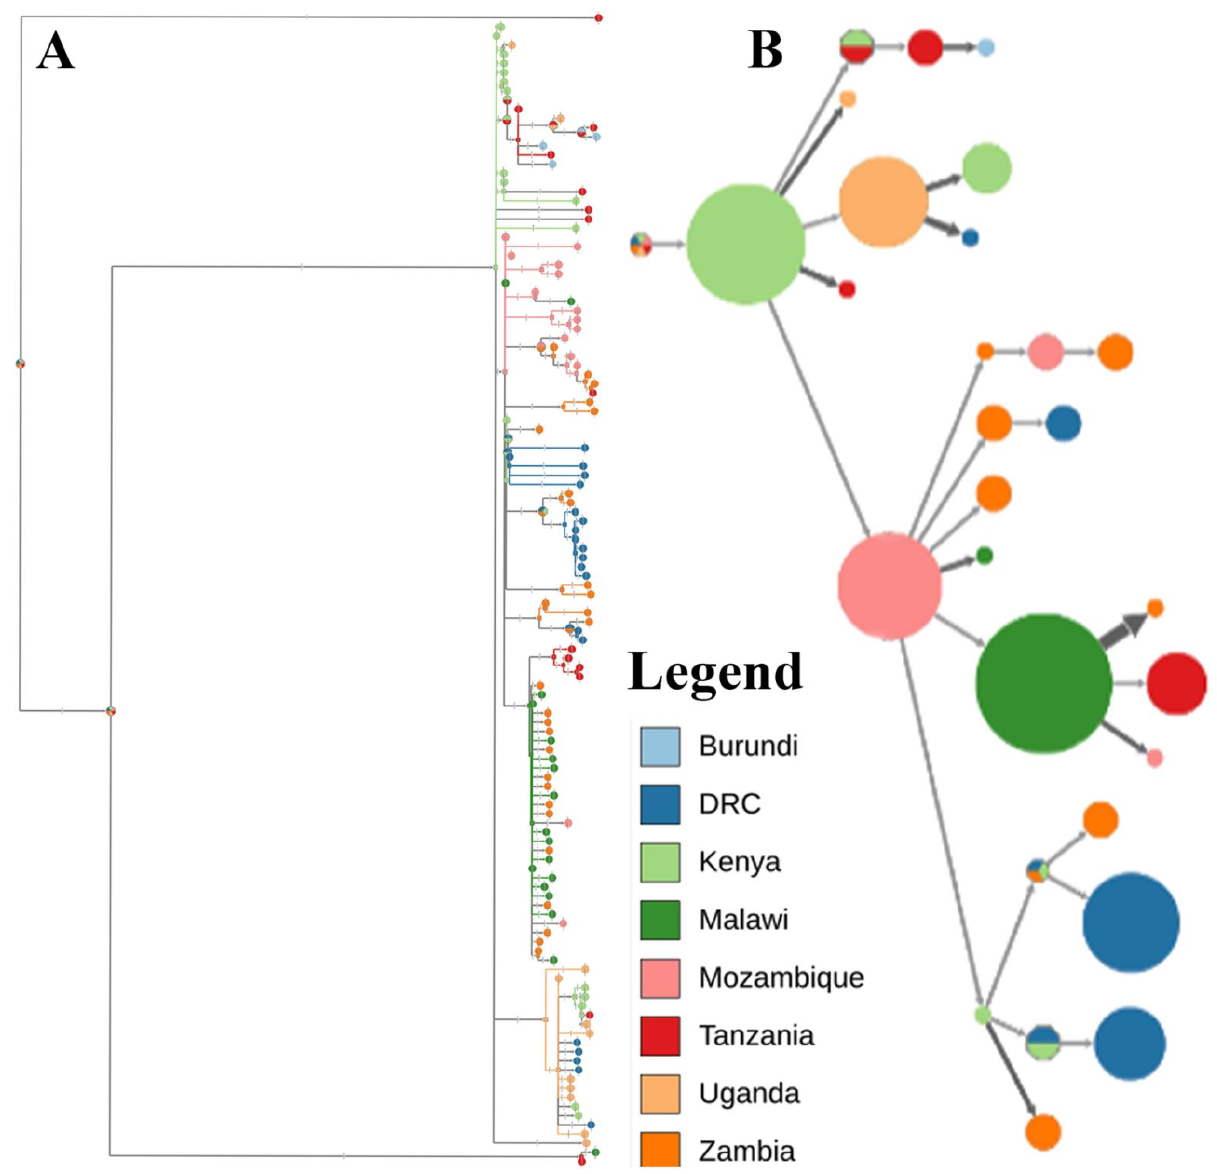
Figure 3. Ancestral reconstruction of African swine fever virus strains collected in Tanzania and its neighboring countries. The figure shows the full tree ( A ) and compressed ( B ) visualizations produced by PastML using MPPA with an F81-like model. Different colors correspond to different countries as shown in the